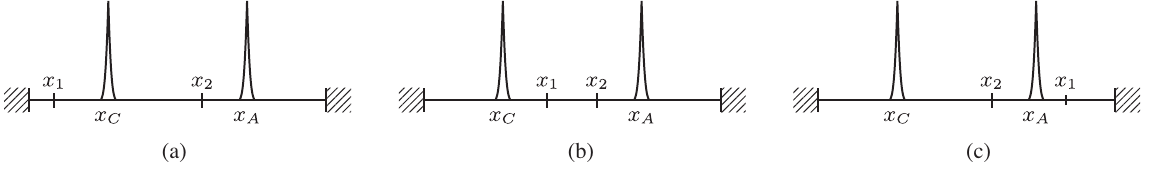
FIG. 8. Entanglement cuts for different cases. In (a) and (c), the subsystem includes only one energy peak. In (b), the subsystem does not include any energy peak. (a) x 1 < x